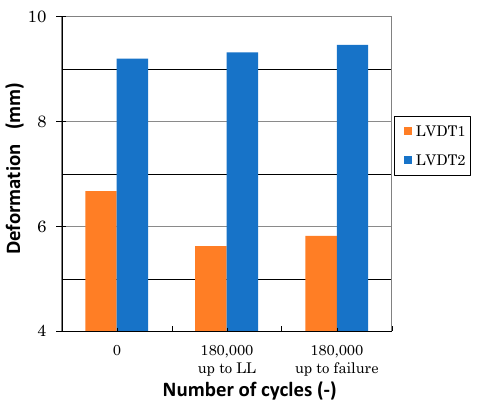
Figure 20. Comparison of LVDT1 and LVDT2 displacement measured at LL before and after fatigue testing.